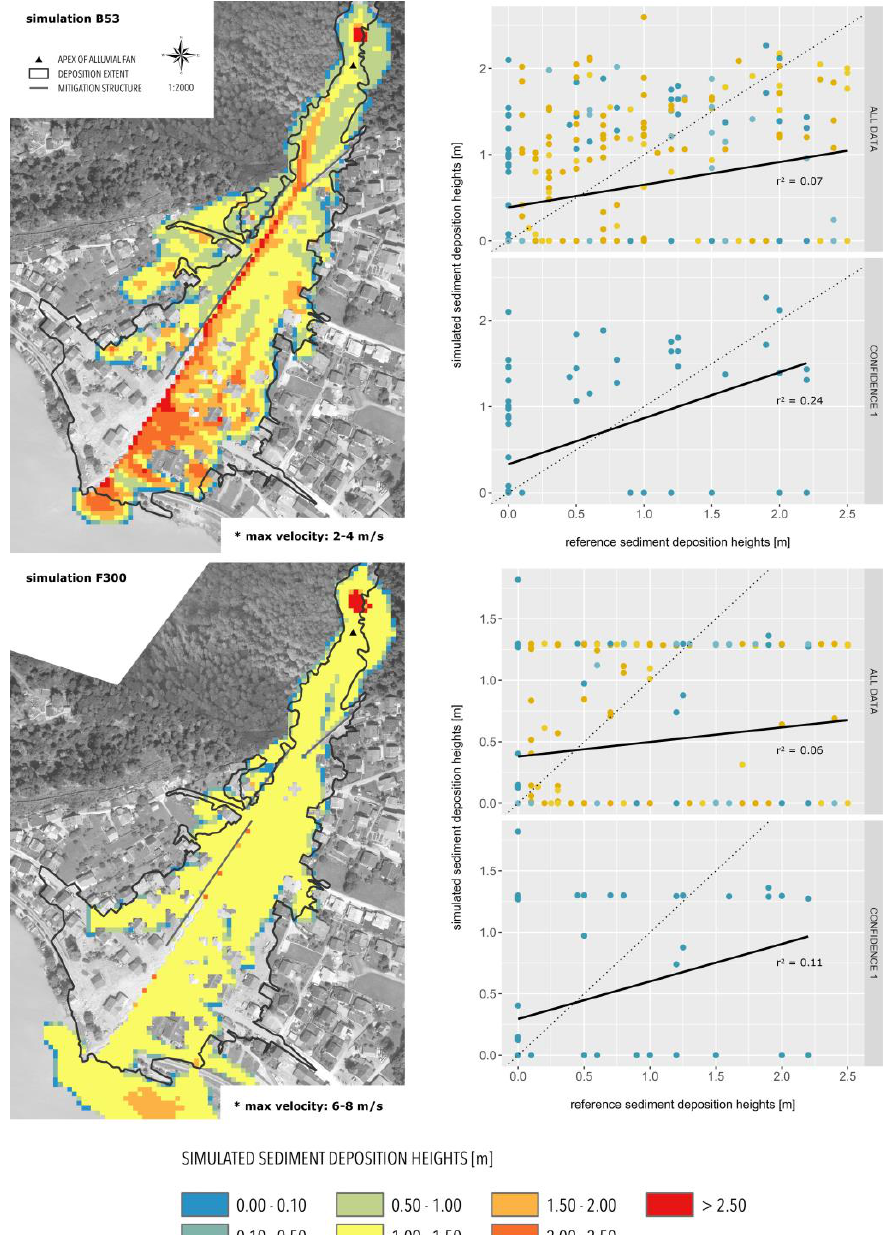
Figure 5. The two selected maps exemplify the agreement between simulated and observed sediment deposition extents, in addition to the spatial distribution of the simulated deposition heights for two of the best performing simulation runs; simulated maximum velocities provide a quick comparison with the point-based velocity estimate of 6 – 8 m/s that was determined by local experts at the Glyssibrücke. Scatterplots with simple linear regression models compared the performance of simulated sediment deposition heights against all of the reference height data and a subset consisting of only very certain height data (Figure 5). The adjusted r 2 value [76] associated with using all of the data ranged from 0.01 to 0.07, while the adjusted r 2 value associated with the subset was relatively higher and ranged from 0.09 to 0.24 (Table 6). For the highest performing model output (i.e., B53), 24.57% of the variance between simulated and reference heights could be explained, an increase of about 17% from using all available observation heights associated with variable confidence